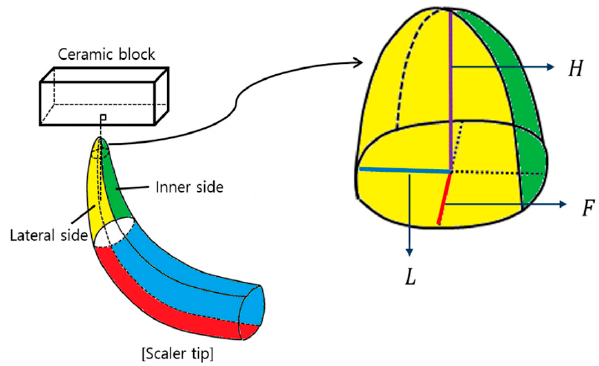
Figure 4. Shape of the stainless-steel ultrasonic scaler tip used for the calculation of the stainless-steel ultrasonic scaler tip wear volume loss.